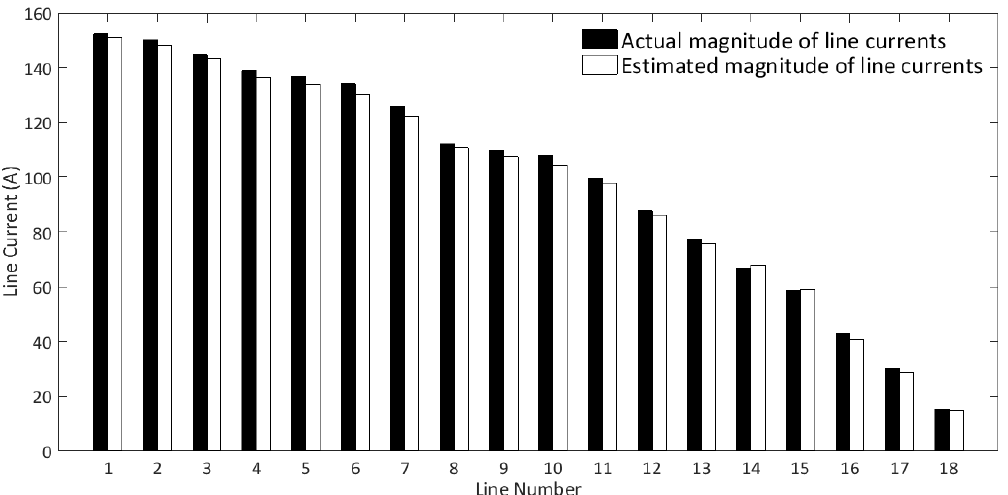
Figure 16. The estimated and actual values of the line currents at 12:00 p.m. (cloudy day).